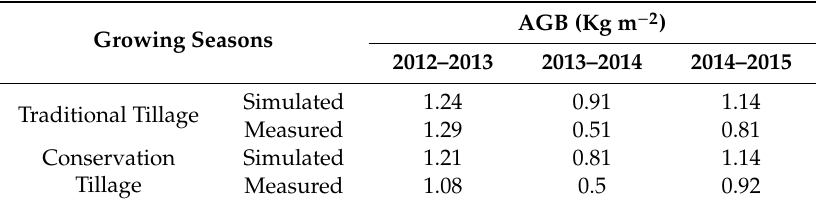
Table 10. Measured aboveground biomass (AGB) and simulated AGB by SWAP model during the three growing seasons for wheat under traditional and conservation